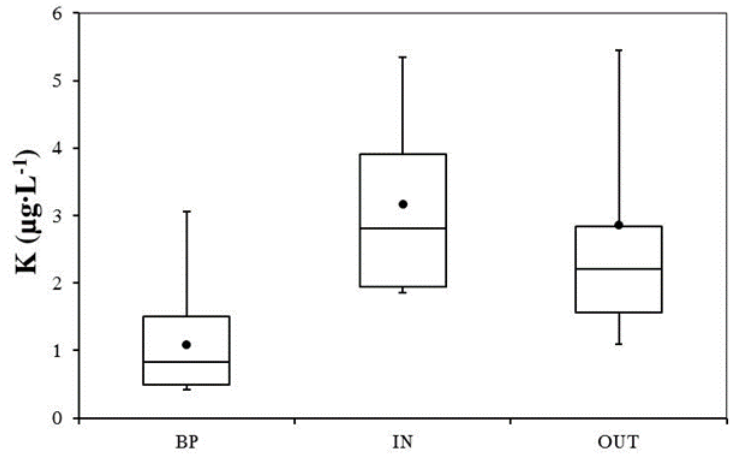
Figure 6. Concentration of potassium (K) in the BP (n = 18 samples), IN (n = 14 samples) and OUT (n = 6 samples) waters. Each box shows the median and range between first and third quartile of all samples, while the whiskers show the minimum and maximum values. The mean (●) is also shown. Salinity takes into account the presence of all ions in water. Salinity values did not change over time and not even differed in inflow and outflow waters (ranging from 44.7 to 89.0 µS cm −1 in BP